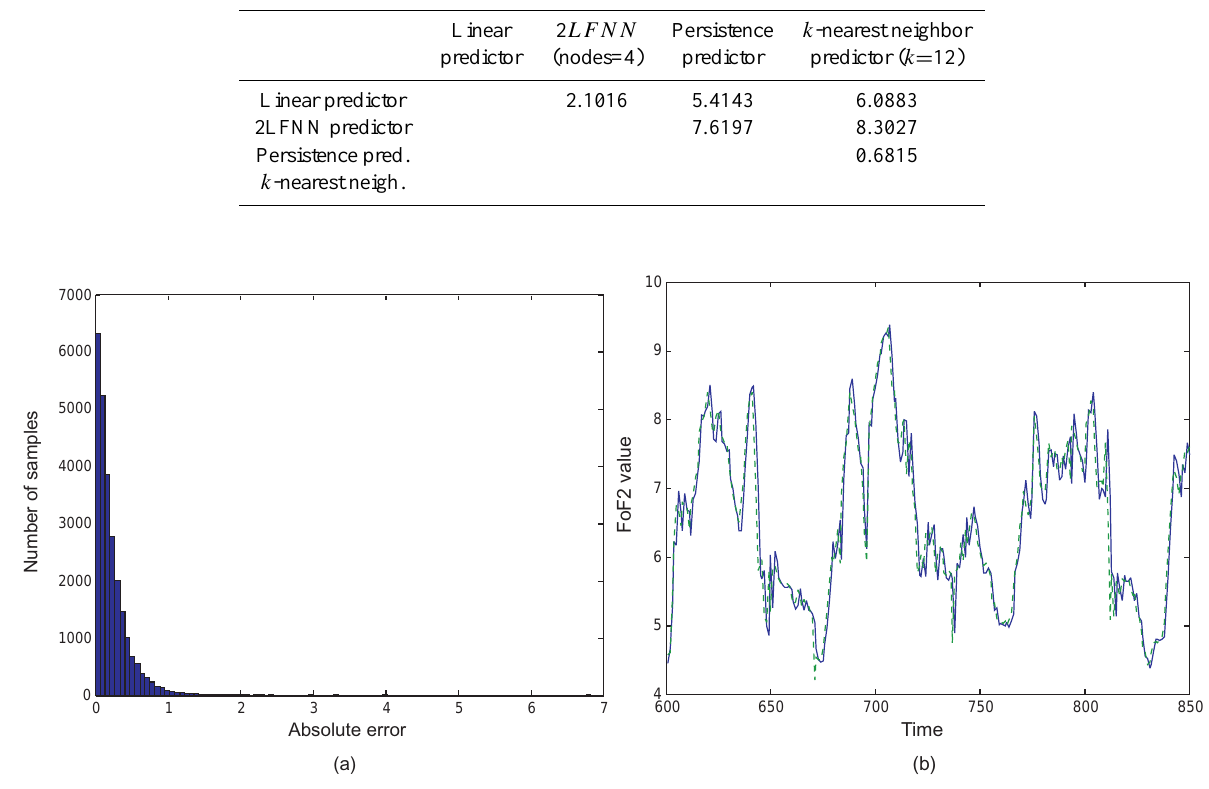
Fig. 3. One-step ahead (15min) prediction, with the 2 LFNN model with 4 nodes. (a) The histogram of the absolute differences of the computed and the actual outputs, for the test set. (b) The actual (solid line) and the computed (dotted line) outputs for a short time interval of the test